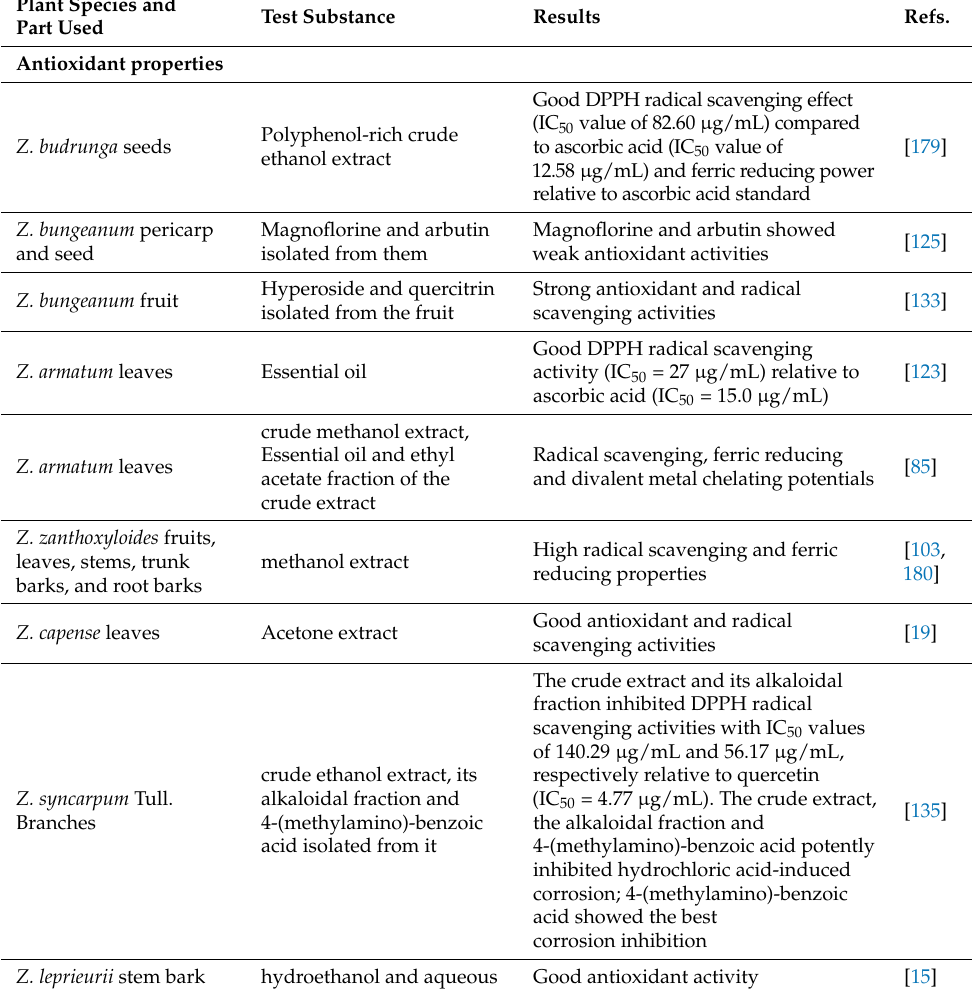
Table 10. Summary of biological activities of Zanthoxylum